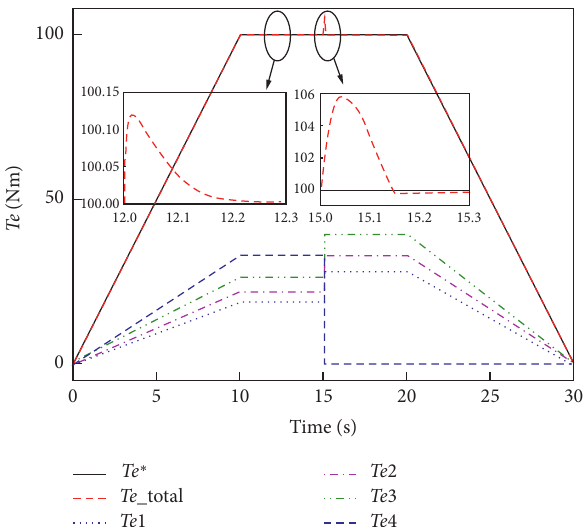
Figure 3: The changing curve of the total traction torque and each motor traction torque output when the fourth motor loses 100% traction torque.